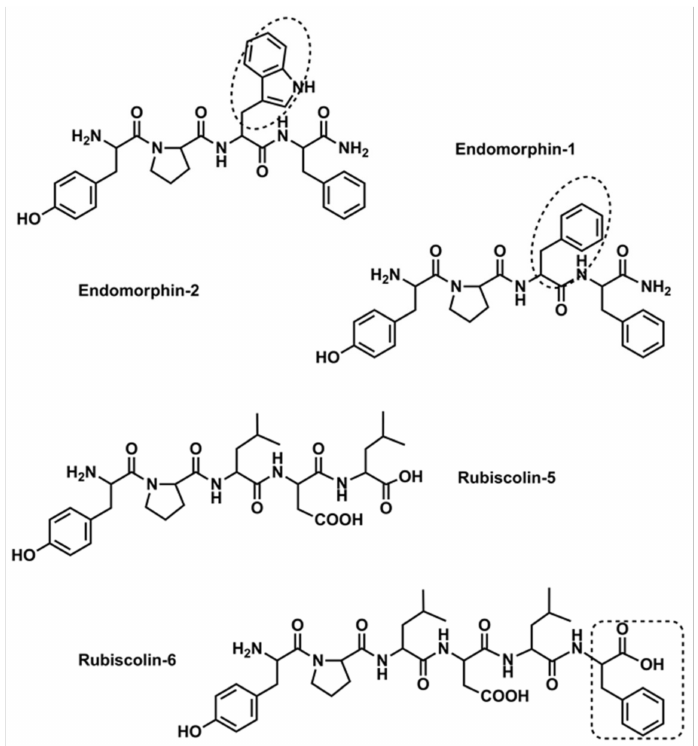
Figure 1. Endomorphin and rubiscolin structures (the differences in chemical structure are indicated with dotted